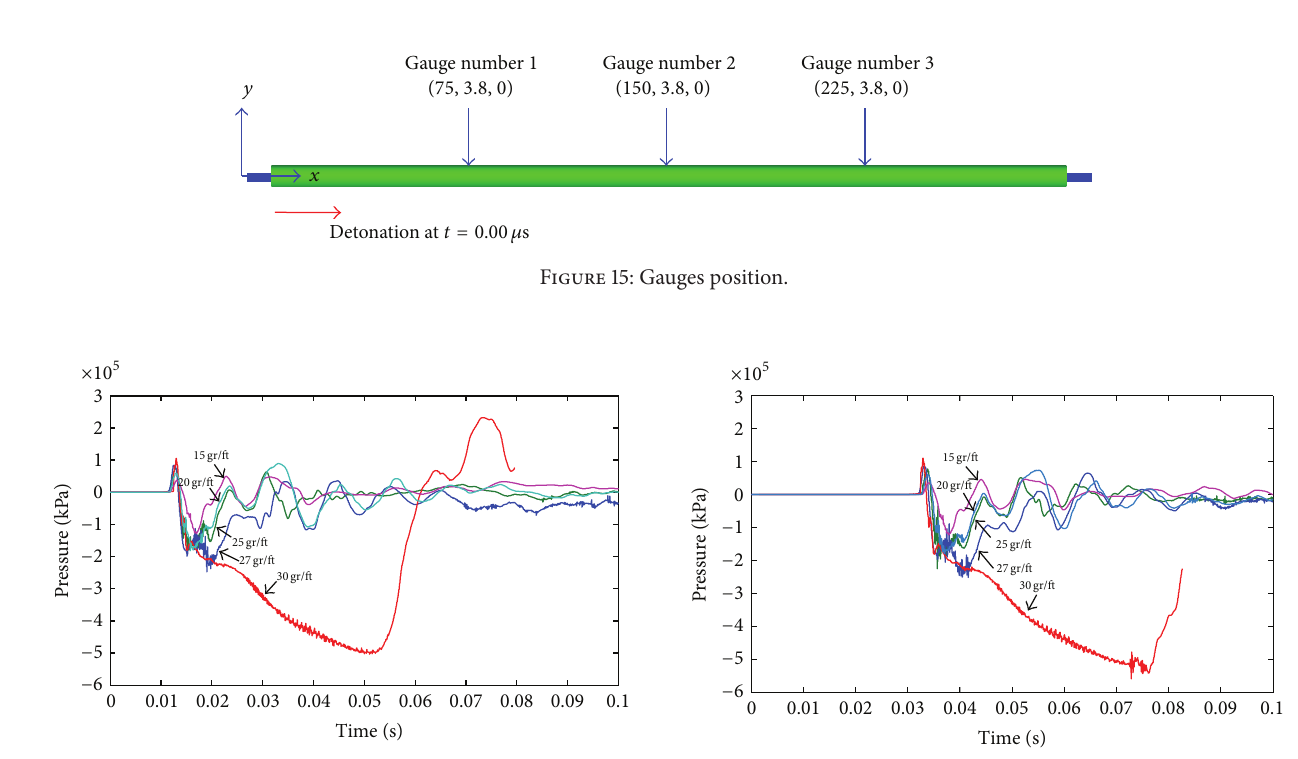
Figure 18: Pressure histories from gauge number